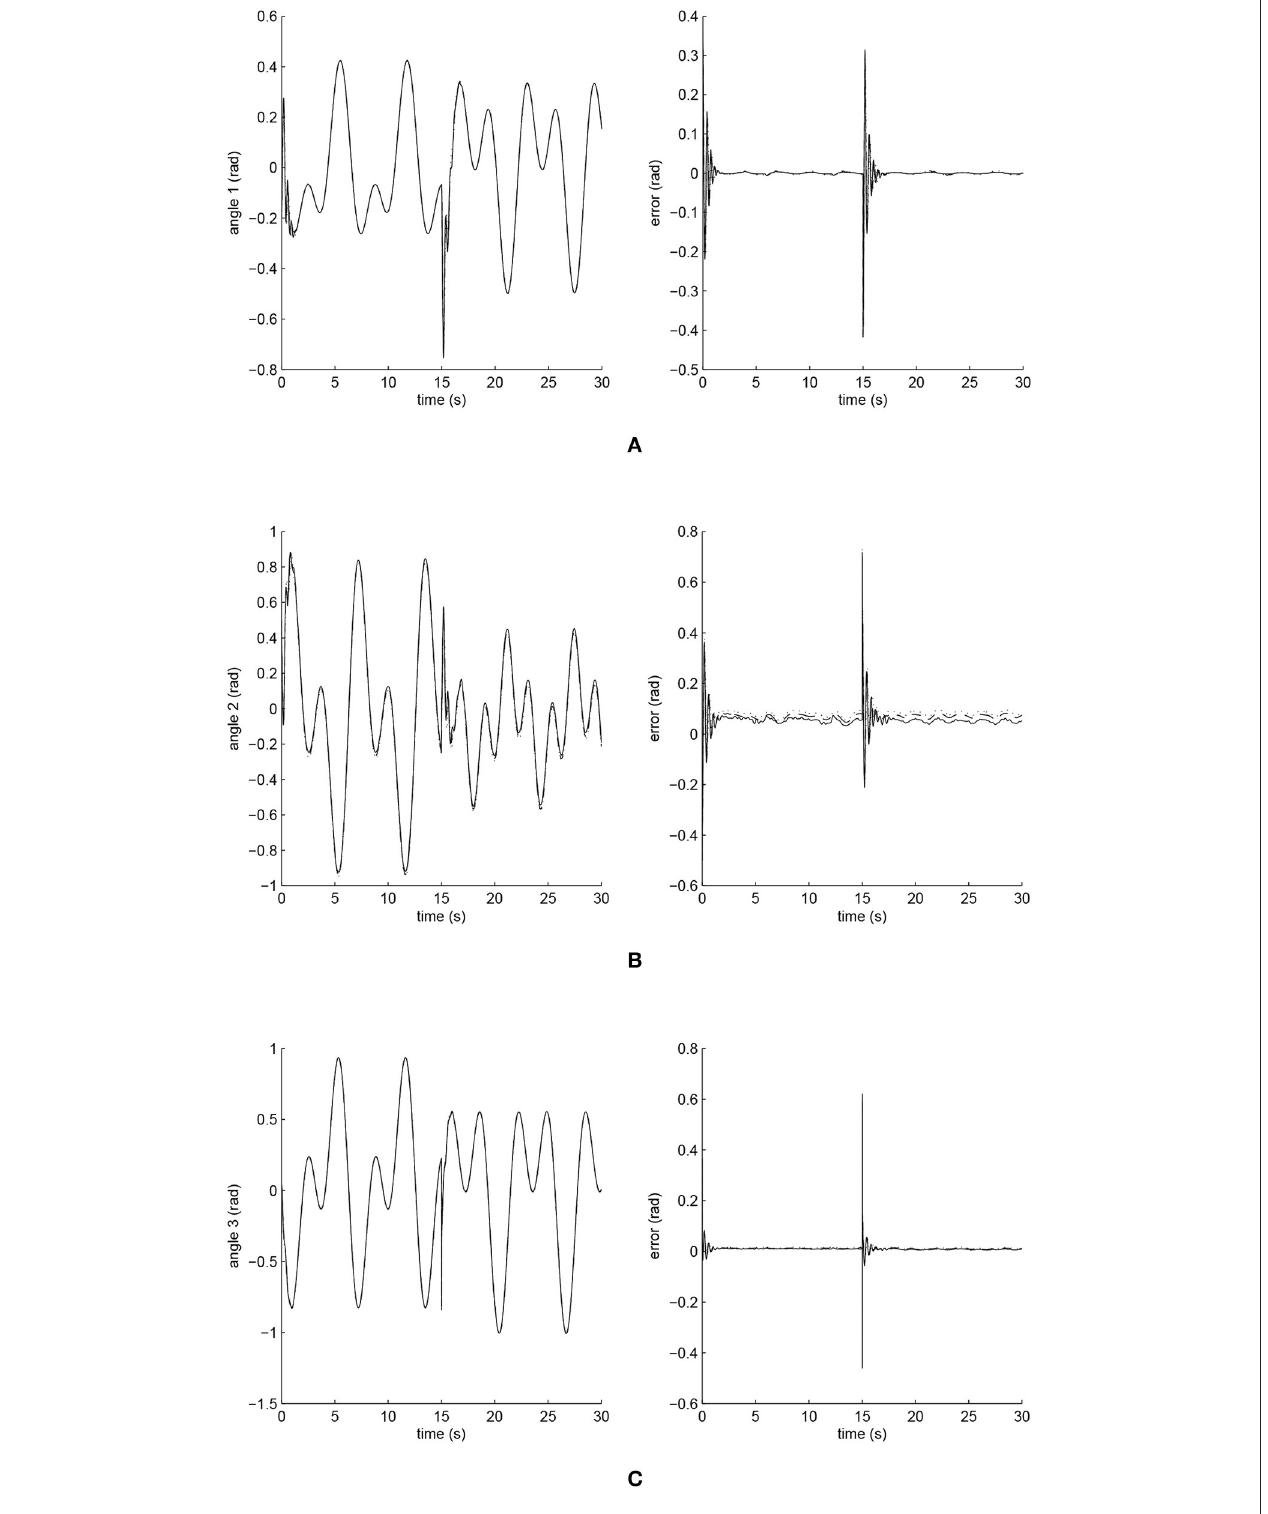
FIGURE 5 | Trajectory responses (in the left) and tracking errors (in the right) of Joints 1, 2, and 3 at ρ 1 = 1. The solid line indicates the performance of the iFBEL; the dotted line represents that of the PID controller; and the dot dash line implies that of the FCMAC controller. (A) Trajectory response and tracking error of Joint 1. (B) Trajectory response and tracking error of Joint 2. (C) Trajectory response and tracking error of Joint 3.